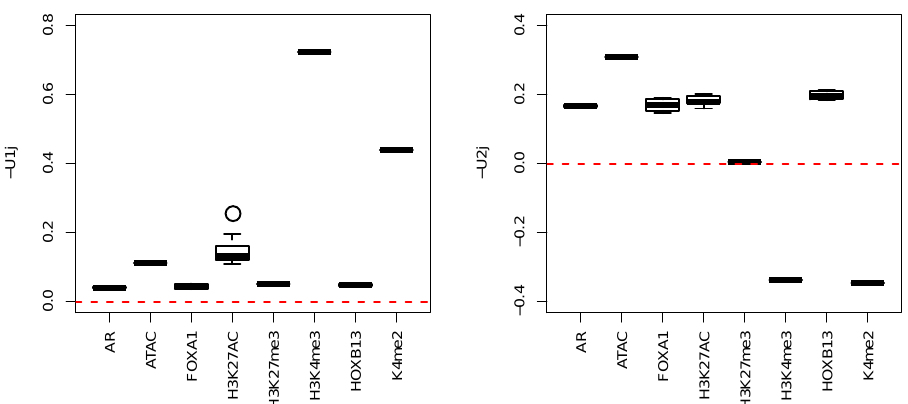
Figure 4. Boxplot of u 1 j and u 2 j when HOSVD is applied to the real